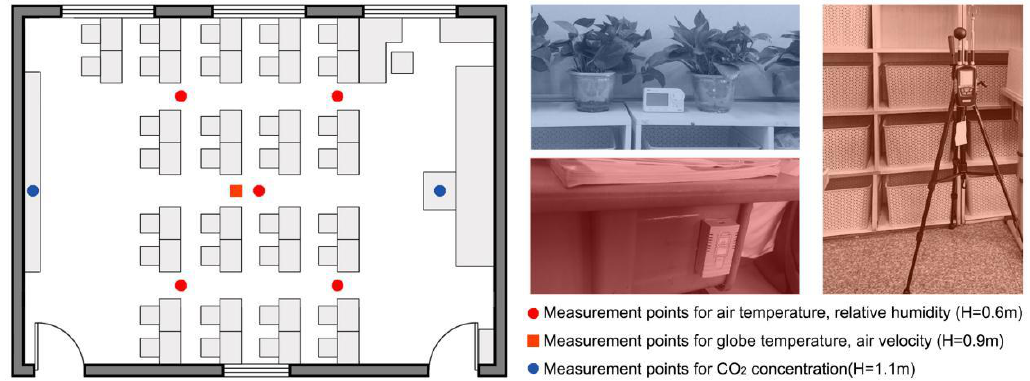
Figure 5. Layout of the measuring points in the classroom. Table 2. Technical specifications of the instruments.